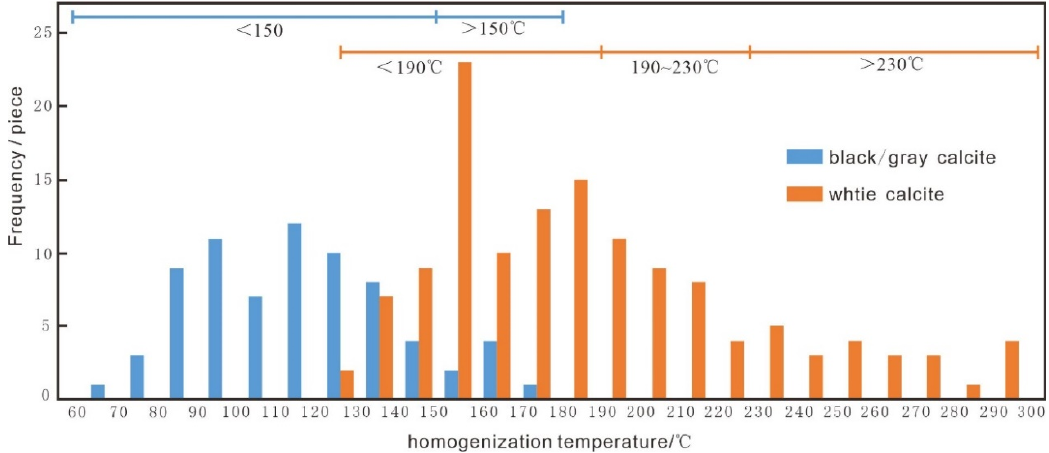
Figure 9. Histogram of homogenization temperatures of the aqueous inclusion from different type calcite. type